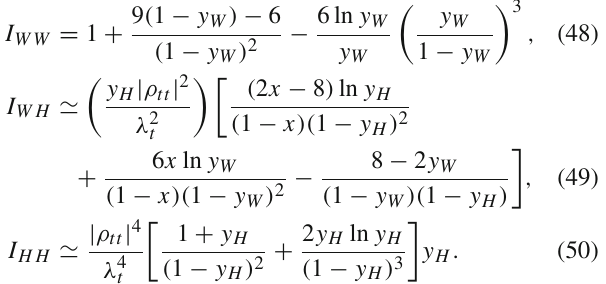
¯ b ) ) based on √ s = 13